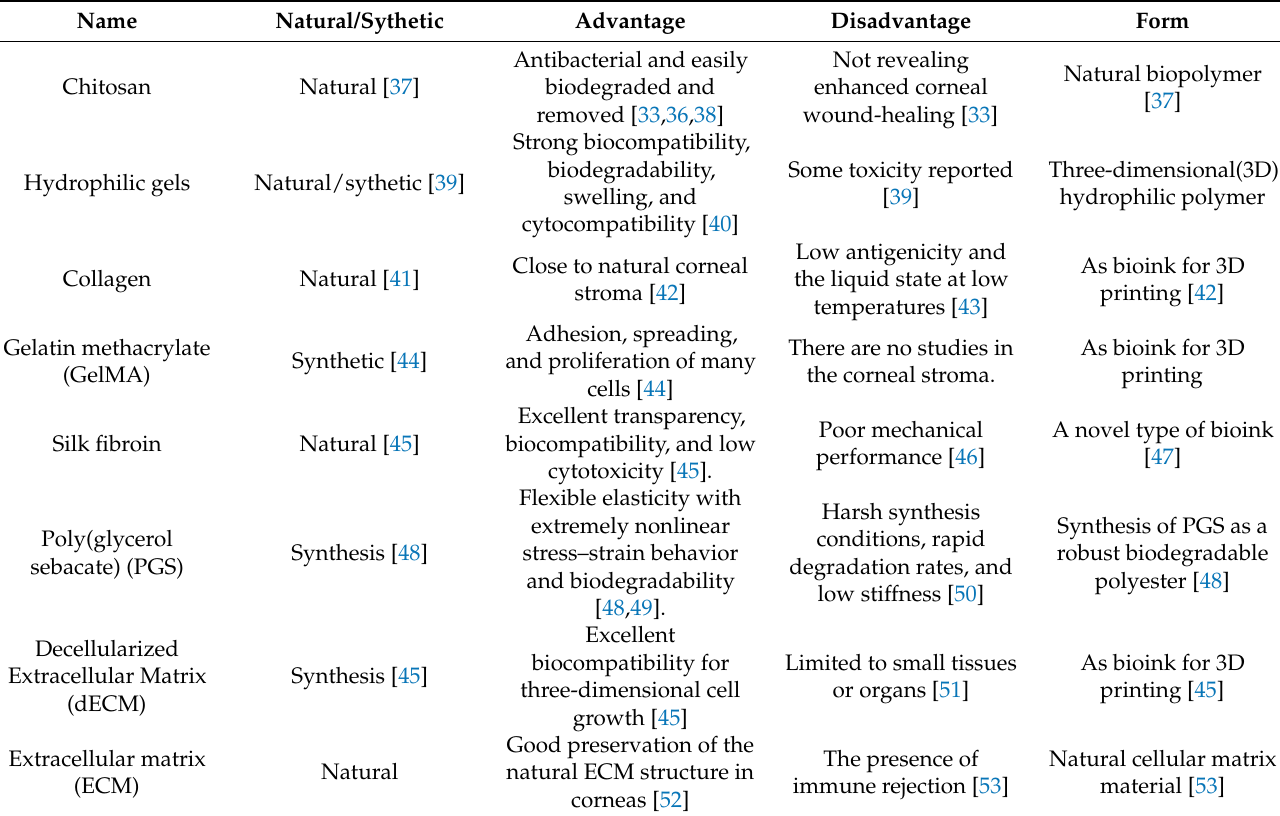
Table 1. Polymer application in